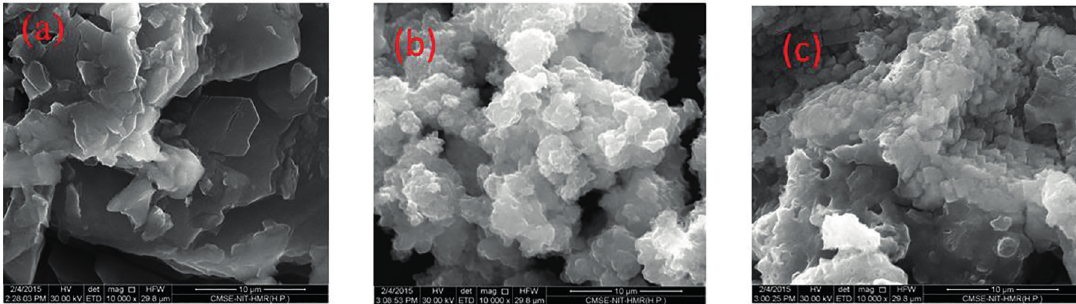
Figure 4: SEM micrographs of (a) nanophotoadduct (b) PPY (c) nanocomposite.